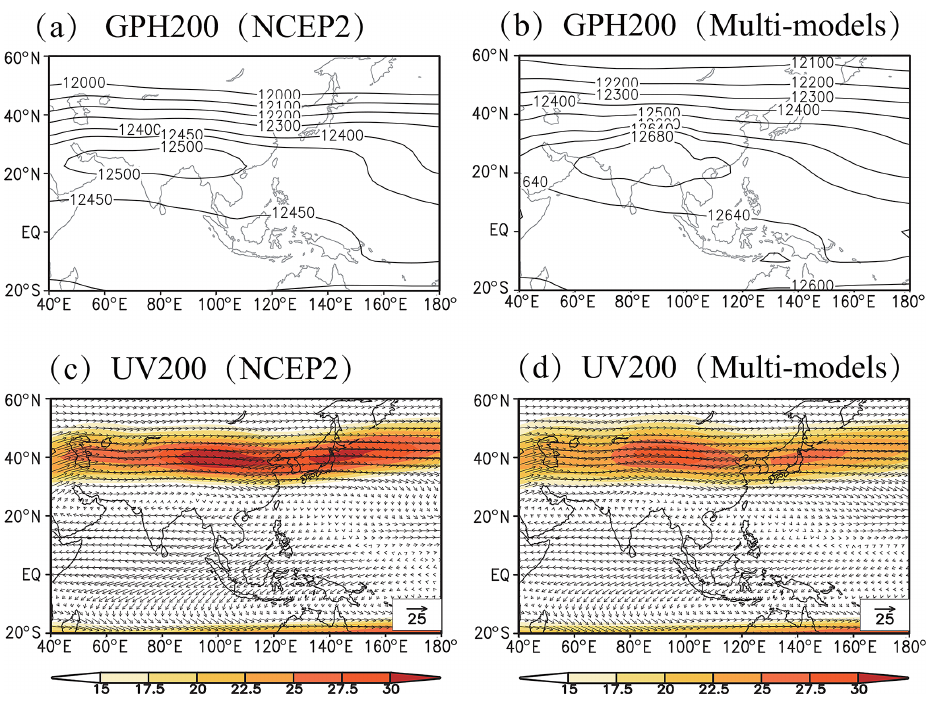
Figure 3. Comparison of the climatological MJJAS mean of 200hPa geopotential height (GPH200; unit: geopotential meters, gpm), 200hPa wind field (UV200; unit: ms − 1 ) and westerly wind speed (shaded; unit: ms − 1 ) between (a, c) observations from 1979 to 2011 and (b, d) multimodel mean of the BASE experiments.